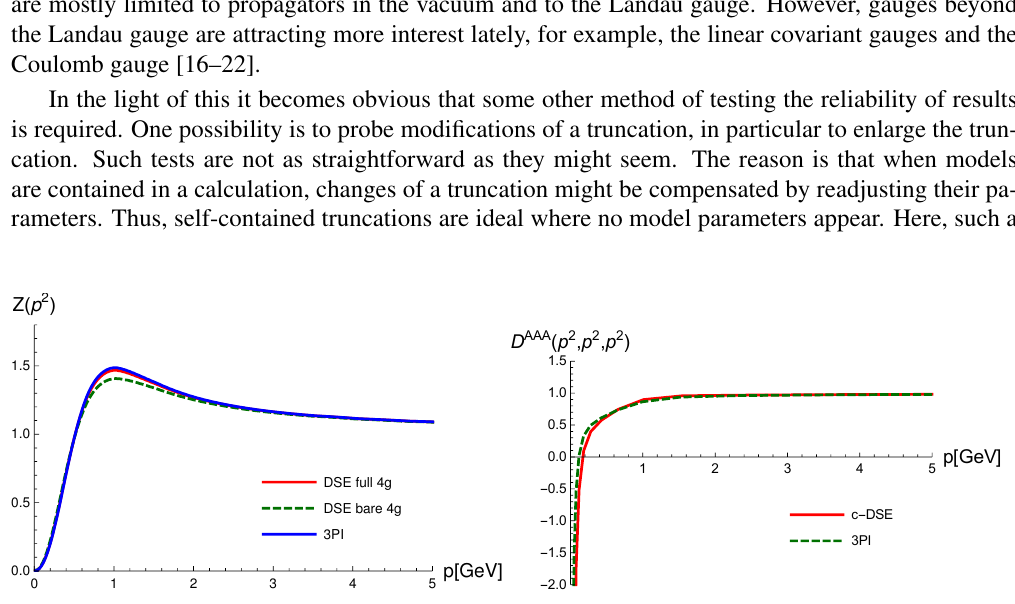
Figure 2. Left: Gluon dressing function of three-dimensional Yang-Mills theory for the truncation shown in Fig. 1 and variations thereof. Right: Three-gluon vertex dressing function from the system of DSEs (red, continuous line) and from the system of equations of motion of the 3PI e (cid:11) ective action (green, dashed line). The results for a bare four-gluon vertex lie on top of the DSE results and are not